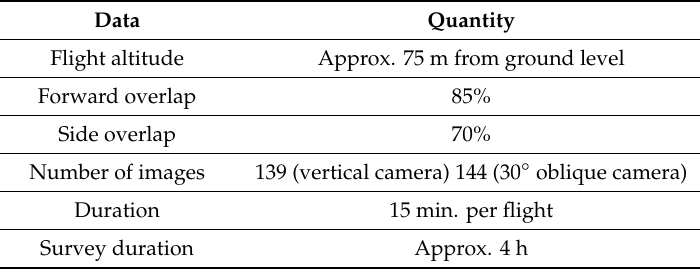
Table 2. Parameters of the photogrammetric acquisition.